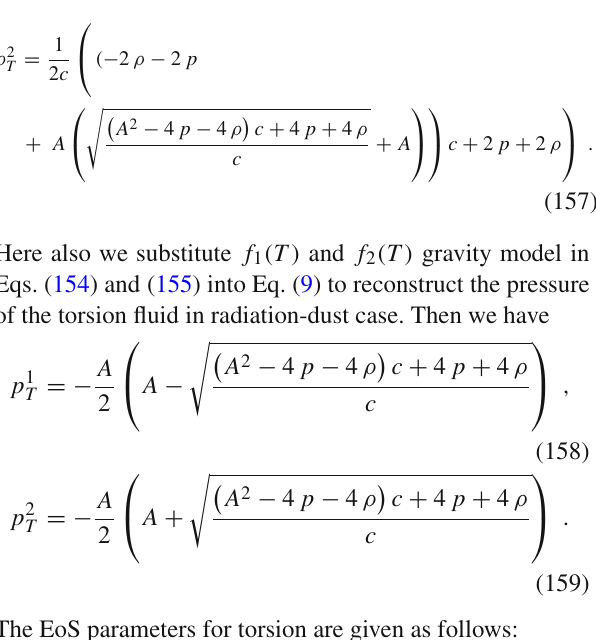
Fig. 11 w ef f ( 1 , 2 ) versus a for radiation- dust-torsion system for GCG. We use c = 1 . 3 and A = 1 for all numerical